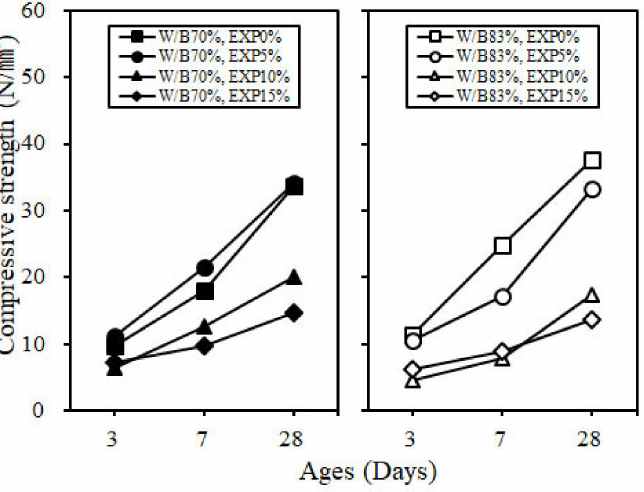
Figure 2. Compressive strength.